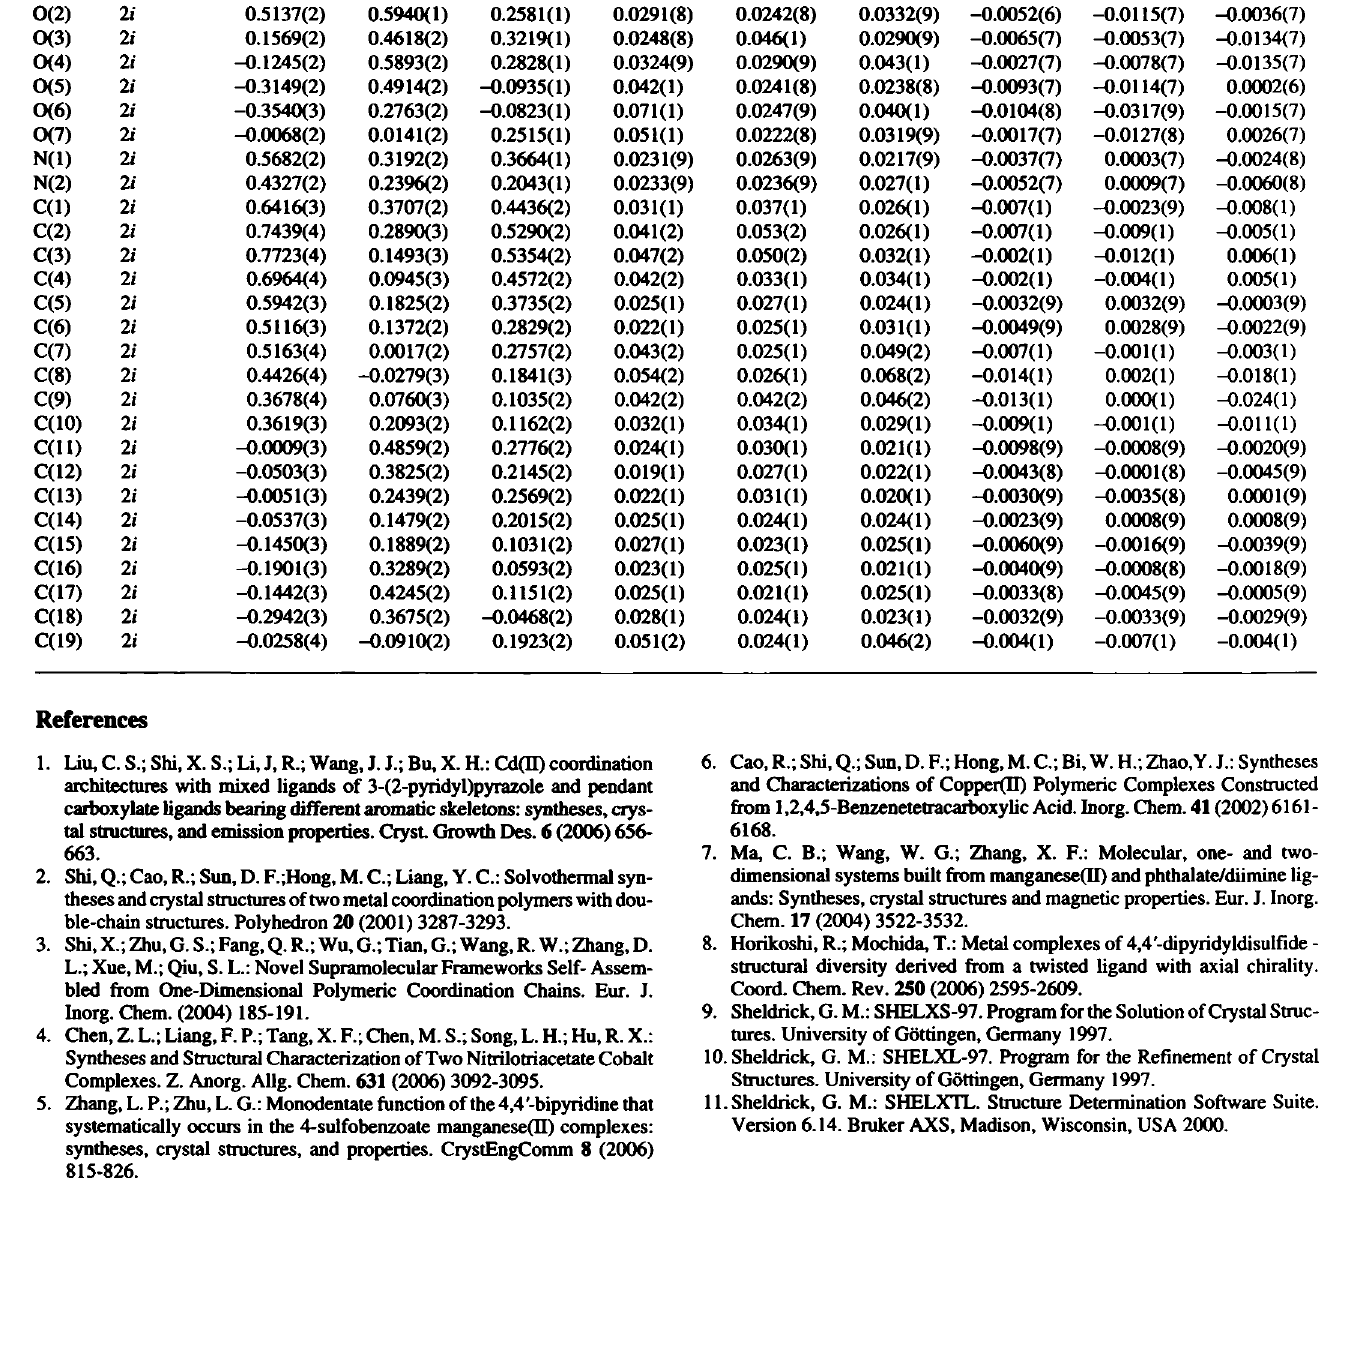
Table 3. Atomic coordinates and displacement parameters (in Â 2